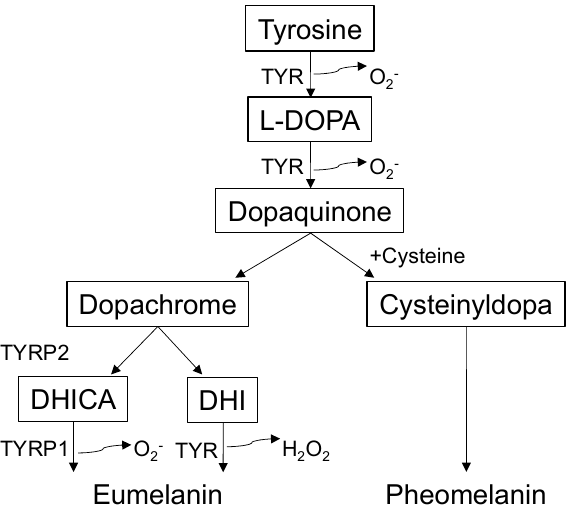
Figure 1. Overview of melanogenesis pathways. Tyrosinase (TYR), the rate-limiting enzyme for melanogenesis, oxidizes tyrosine to L-3,4-dihydroxyphenylalanine (L-DOPA) and dopaquinone. Dopaquinone reacts with excess cysteine/glutathione and generates cysteinyldopa, giving rise to pheomelanin. With cystine/glutathione disulfide abundance, dopaquinone generates dopachrome. Dopachrome undergoes spontaneous decarboxylation and forms 5,6-dihydroxyindole (DHI). In the presence of tyrosinase-related protein 2 (TYRP2), dopachrome produces 5,6-dihydroxyindole-2-carboxylic acid (DHICA) through tautomerization. TYR and tyrosinase-related protein 1 (TYRP1) catalyze further conversions, yielding eumelanin. The catalytic activity of TYR or TYRP1 generates superoxide anions (O 2− ) and hydrogen peroxide (H 2 O 2 ).